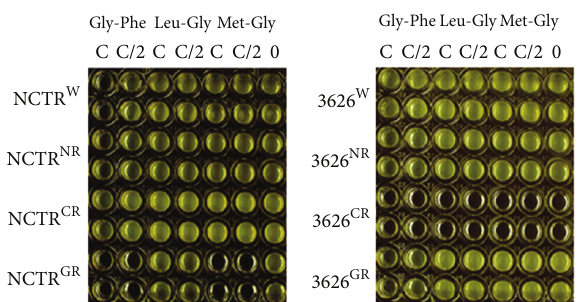
Figure 1: Comparison of growth of fluoroquinolone-resistant mutants of NCTR and 3626 with the growth of the wild types in the presence of three dipeptides. W, NR, CR, and GR refer to wild type,norfloxacin-resistant,ciprofloxacin-resistant,andgatifloxacin- resistant, respectively. Statistically significant differences were observed in the growth of strains ( 𝑃 < 0.05 ). C indicates the dipeptide concentration equivalent to the proprietary concentration of the compounds in the Biolog microtiter plate that had affected the bacterial growth or survival. C/2 is half of the concentration of dipeptide used in the Biolog microtiter plate. 0 is Biolog medium with no dipeptide added. This medium was used in all the wells for the dipeptide experiments. The dipeptides used in this experiment were selected based on the effects observed in experiments using Biolog